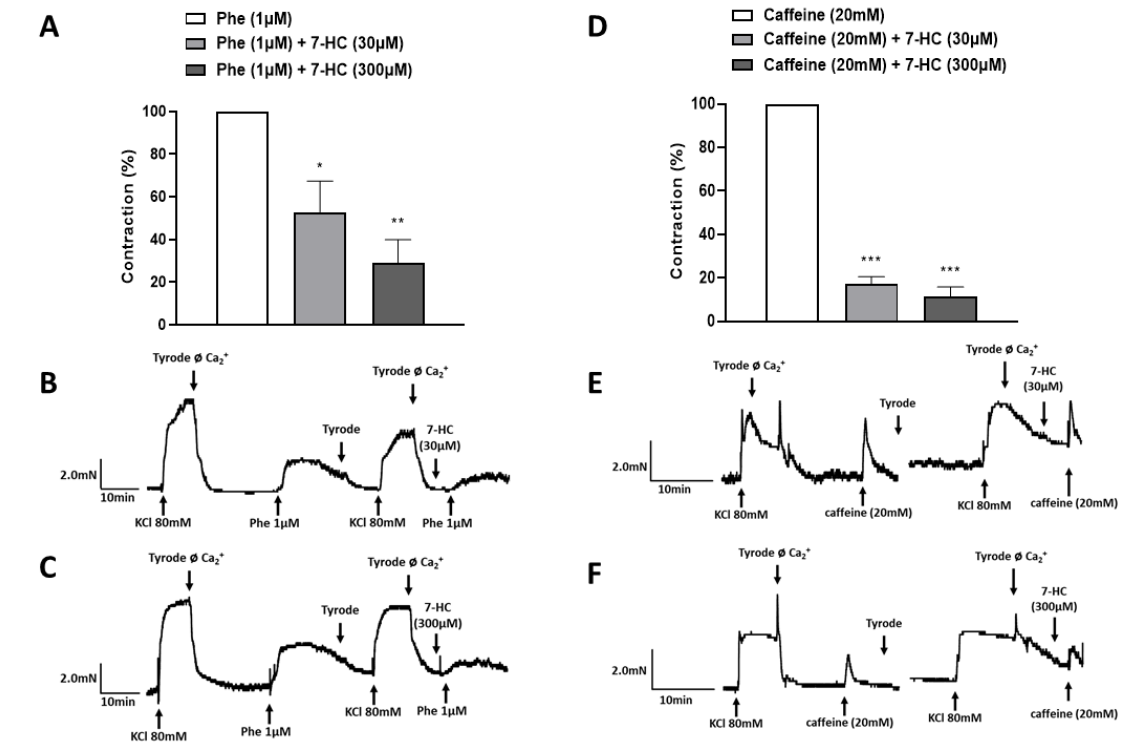
Figure 5 . Effect of 7-HC on the mobilization of intracellular Ca 2+ . Bar graphs showing the effect of 7-HC ( 30 μM and 300 μM ) on the Ca 2+ mobilization from phenylephrine-sensitive ( A ) and caffeine-sensitive ( D ) intracellular stocks in a Ca 2+ -free Tyrode solution. Representative recordings of the effects of 30 μM and 300 μM 7-HC on isolated mesenteric artery rings incubated with 1 μM phenylephrine ( B , C ) or 20 mM caffeine ( E , F ) in a calcium-free solution. The results are expressed as means ± S.E.M. Statistical analysis was performed using one-way ANOVA followed by Bonferroni’s post-test. * p < 0.05, ** p < 0.01, or *** p < 0.001 versus Phe ( A ) or caffeine ( D ).